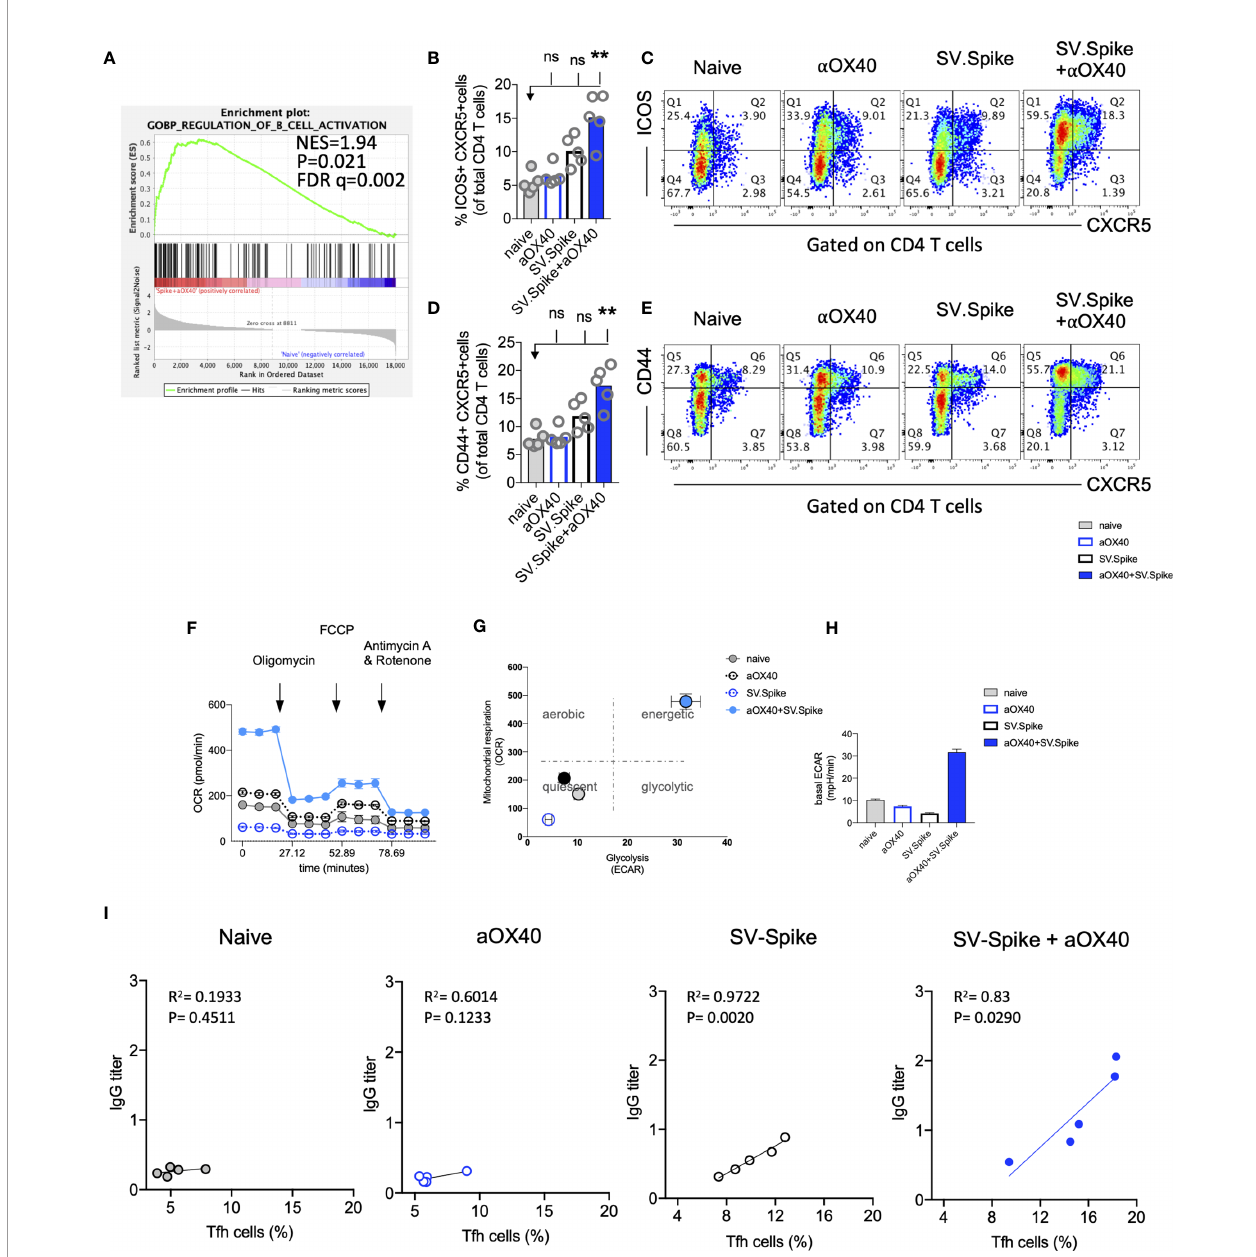
FIGURE 8 | SV.Spike in combination with a OX40 drives follicular T helper cell function and metabolic activation of B-cells. C57BL/6J mice were vaccinated with SV.Spike and/or a OX40. Naive mice were used as control. T cells were isolated on day 7 after prime vaccine doses and RNAseq was performed (A) . GSEA for biological processes identi fi ed pathway enrichment that regulates B-cell activation after prime vaccine doses in combination immunized mice. Splenocytes were excised on day 21 for fl ow cytometry analysis (B – E) . (B, C) CXCR5+ICOS+ expressing CD4+ T cells and (D, E) CXCR5+CD44+ expressing CD4+ T cells indicating Tfh-cell differentiation with representative plots (n=5 individual mice per group). (F – H) B cells were isolated for Seahorse metabolic fl ux analysis one week after boost doses. (F) Mitochondrial respiration was assessed by measuring the median values of oxygen consumption rates (OCR) in B cells of indicated groups using an extracellular fl ux analyzer. Oligomycin, FCCP, Antimycin A, and Rotenone were injected as indicated to identify energetic mitochondrial phenotypes. (G) Energy Map (OCR versus ECAR) of B cells from naïve or mice treated with SV.Spike and/or a OX40 on day 21. (H) Baseline extracellular acidi fi cation rates (ECAR) in B cells of indicated groups. Error bars indicate SEM. Results are representatives of one or two independent experiments. Bars or symbols represent means ± SEM, and statistical signi fi cance was determined with the Kruskal-Wallis test followed by Dunns ’ test. n.s. > 0.05, **p<0.005. (I) Correlation analysis of ICOS+CXCR5+ expressing Tfh cells with IgG antibody titers at 21 days post vaccination. (n=5). Pearson ’ s rank correlation coef fi cients (R) and p values are